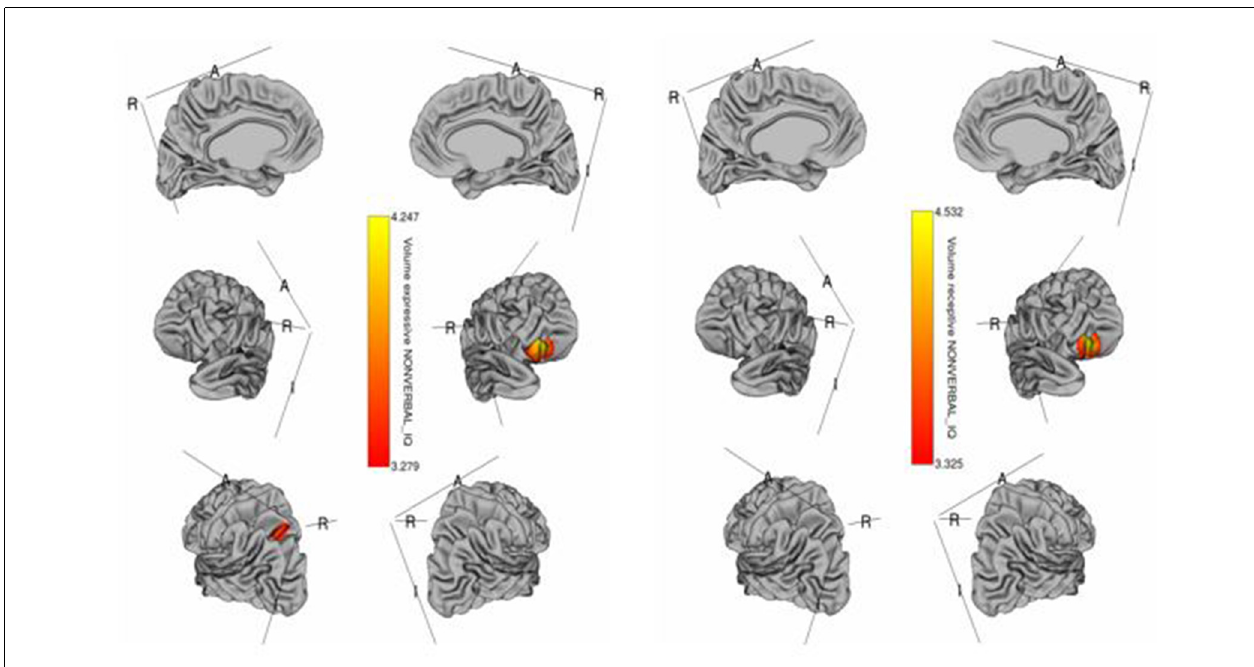
FIGURE 2 | Brain regions where cortical volume is significantly associated with receptive (right) and expressive (left) language scores across diagnostic groups. Colored vertices depict t -statistics for the effect of cortical volume in vertex the specific regression where the vertex was significant after FDR